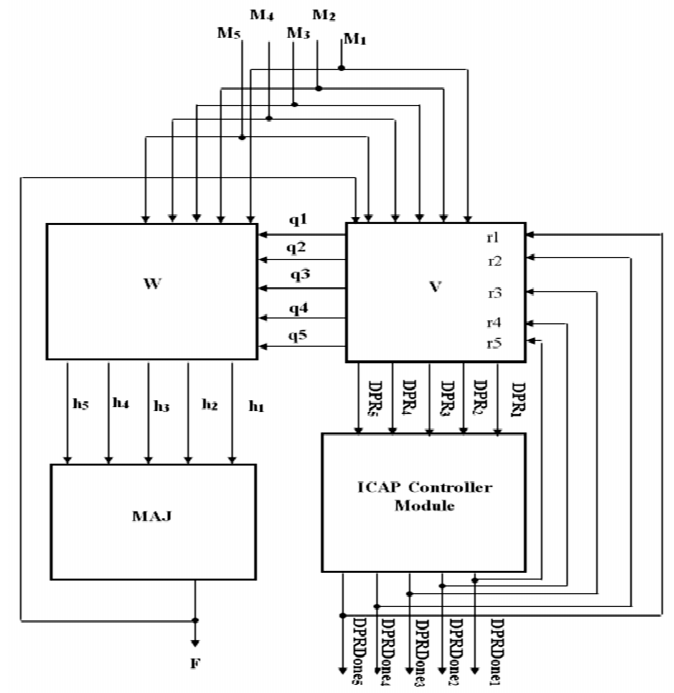
Electronics 2020 , 9 , x FOR PEER REVIEW Figure 5. The 5MR reconfiguration scheme. Figure 5. The 5MR reconfiguration scheme.